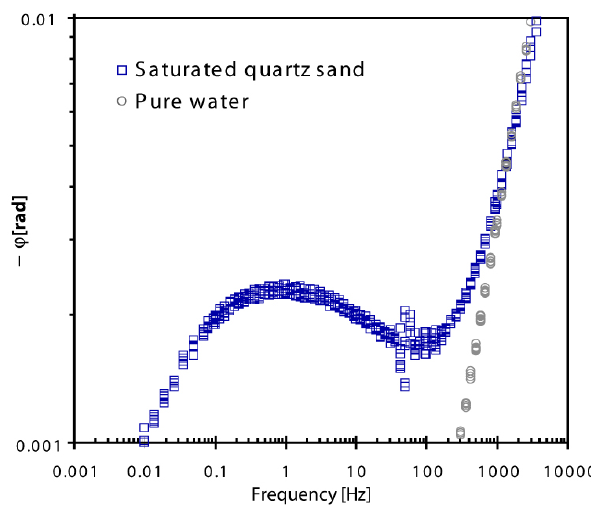
Fig. 3. Example of phase spectra obtained from SIP measurements on a saturated sample of sand F36 (Table 1) as well as on the cor- responding saturating pore water alone. The latter had an electrical conductivity of ∼ 60µS/cm. Note the negative scale for the